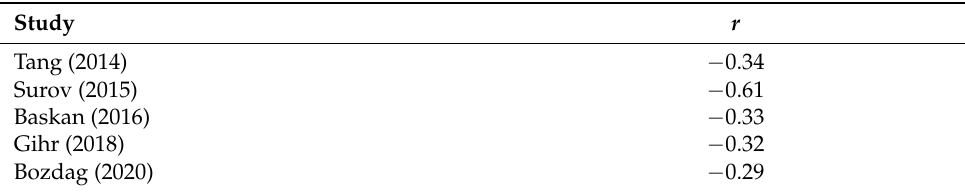
Table 3. Correlation coefficients ( r ) between mean ADC and